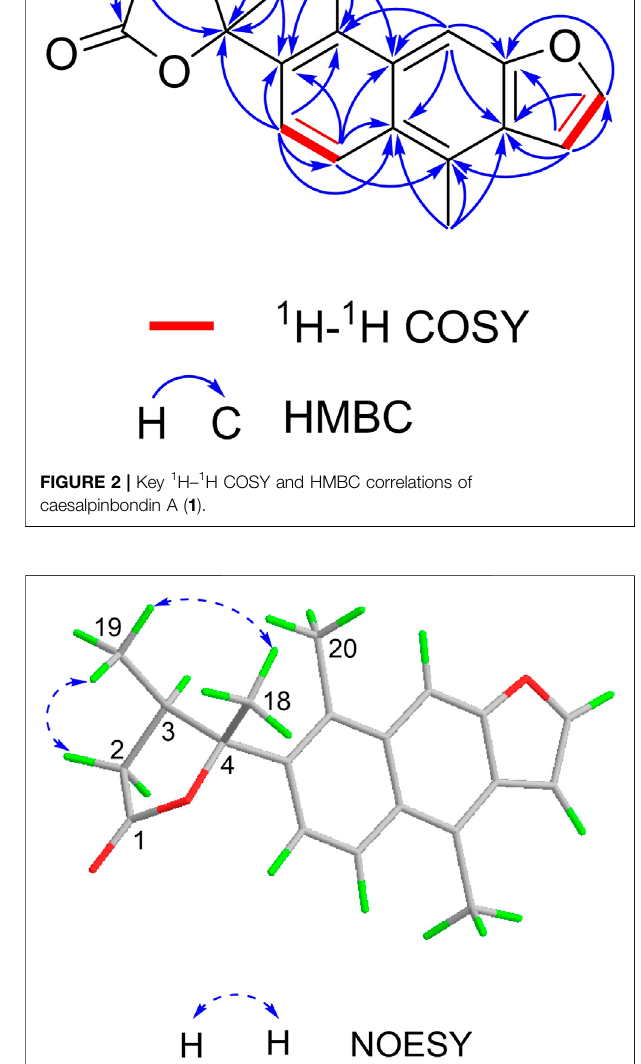
FIGURE 3 | Key NOESY correlations of caesalpinbondin A ( 1 ).